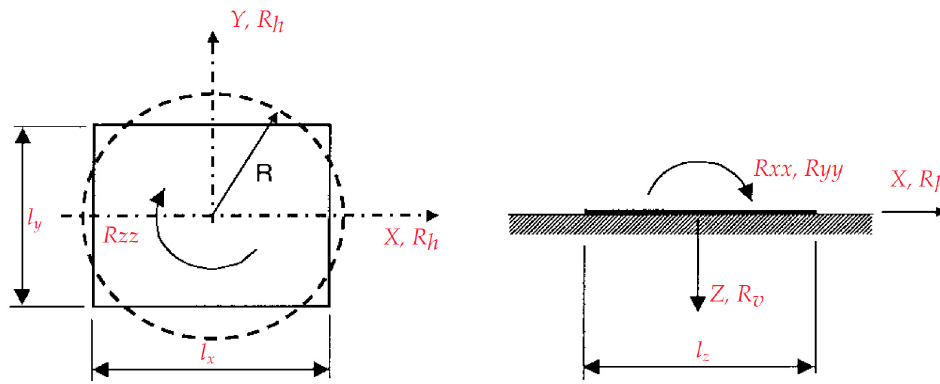
Figure 3. Notation for calculation of equivalent radii for rectangular bases.